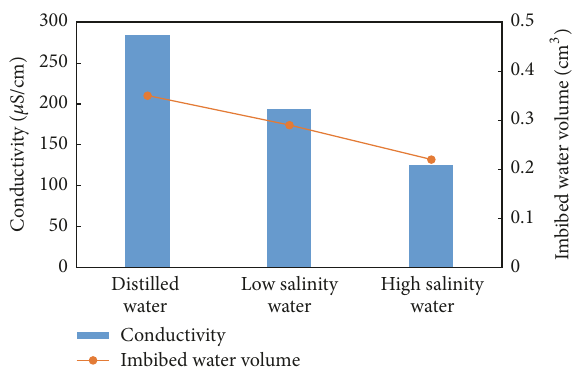
Figure 5: Final conductivity changes and imbibed water volumes for Case 1.